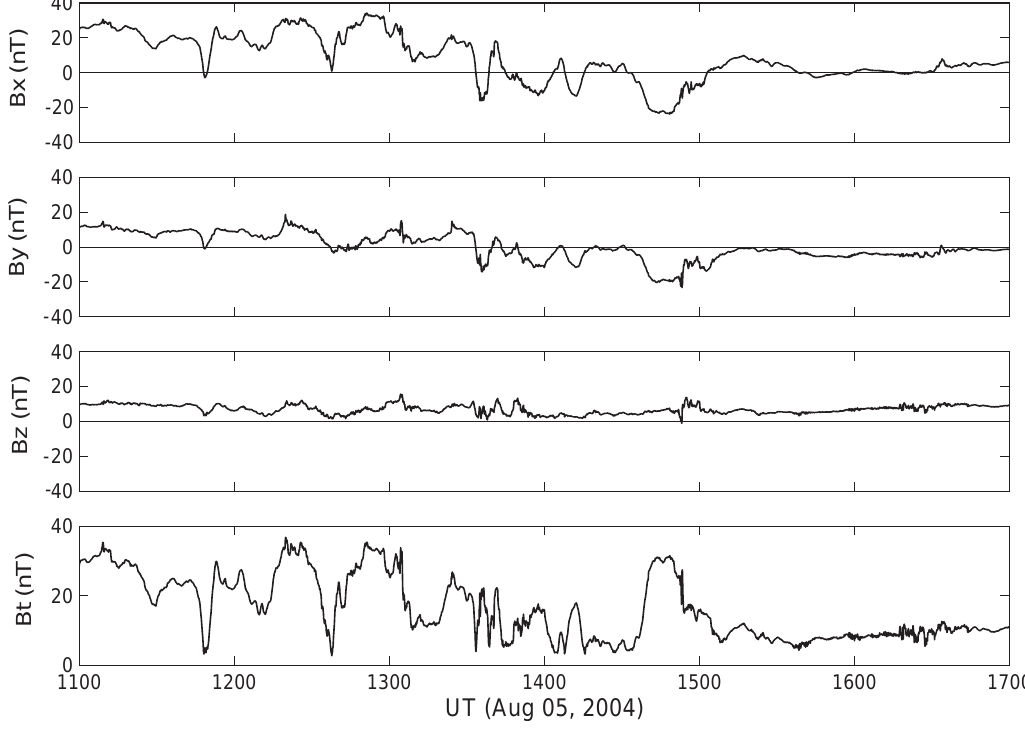
Figure 1b. TC-1 magnetic field in GSM coordinates.